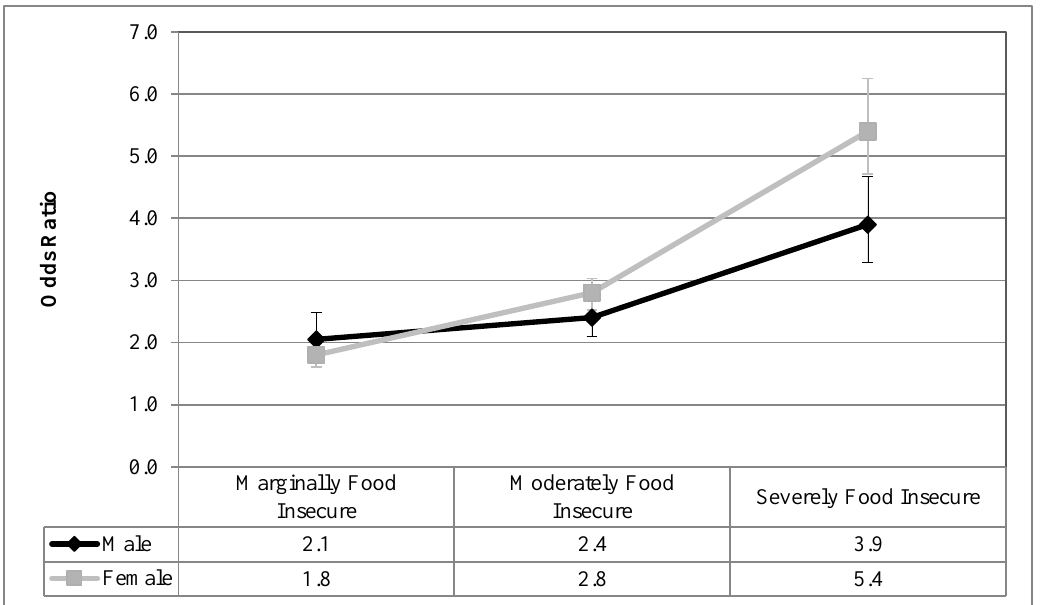
Figure 2. Odds ratio of reporting anxiety disorders for each level of household food insecurity stratified by sex, compared with food secure; results from reduced binary logistic regression. Int. J. Environ. Res. Public Health 2019 , 16 , x